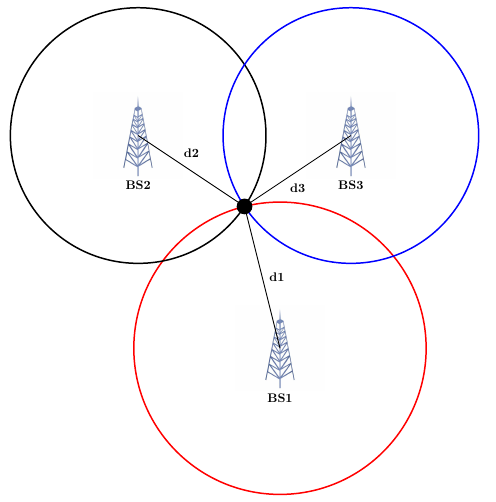
Figure 1. Trilateration: localisation based on the range from 3 anchors (TOA,